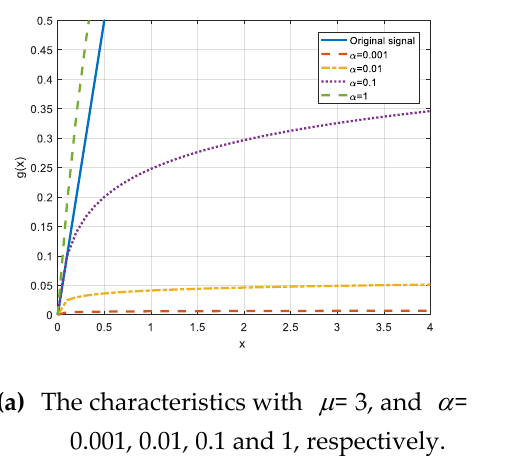
Figure 1. The characteristics of the modified law algorithm with different parameters.